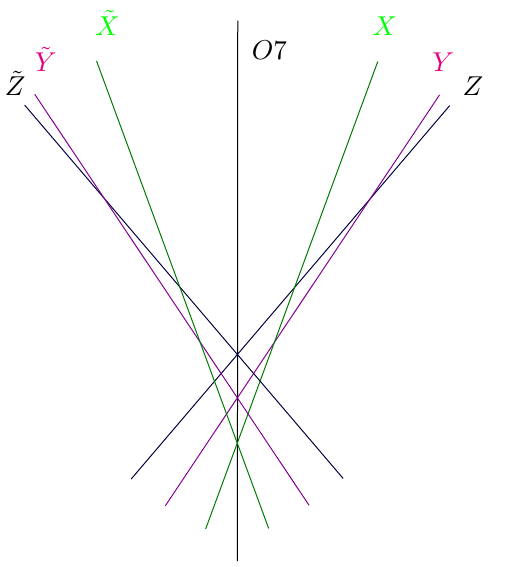
Figure 4 . Depiction of the three U(1) brane stacks in the presence of the orientifold plane O